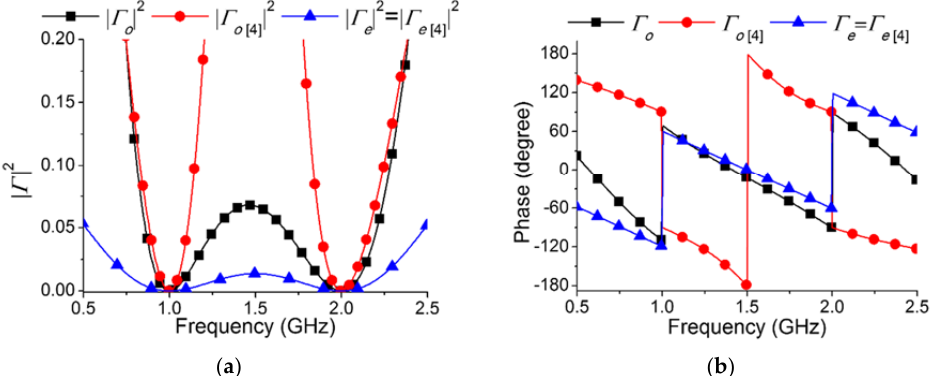
Figure 5. The ( a ) magnitude and ( b ) phase of the even ‐ and odd ‐ mode reflection coefficients for this work and a previous study [4].